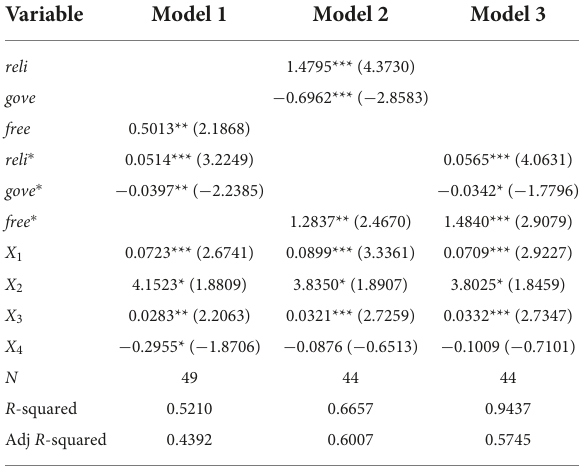
TABLE 5 Regression results with replacement of explanatory variables.